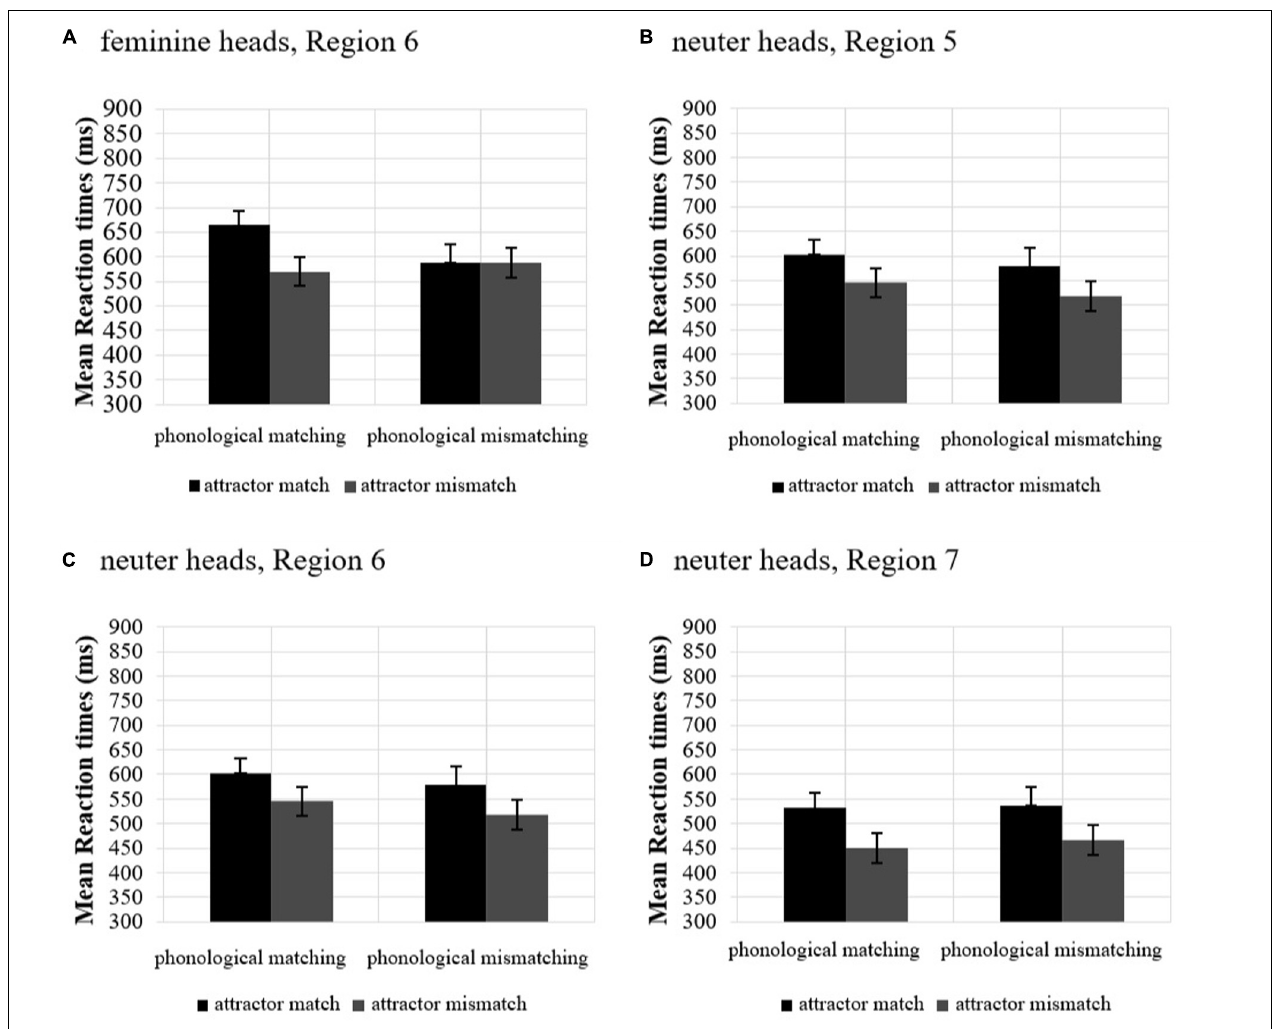
FIGURE 4 | Mean reaction times in ungrammatical sentences by Attractor (match, mismatch) and Phonological matching (phonological matching/mismatching) in feminine heads, Region 6 (A) , neuter heads, Region 5 (B) , neuter heads, Region 6 (C) , and neuter heads, Region 7 (D) in Experiment 2. Error bars indicate the standard error of the mean across